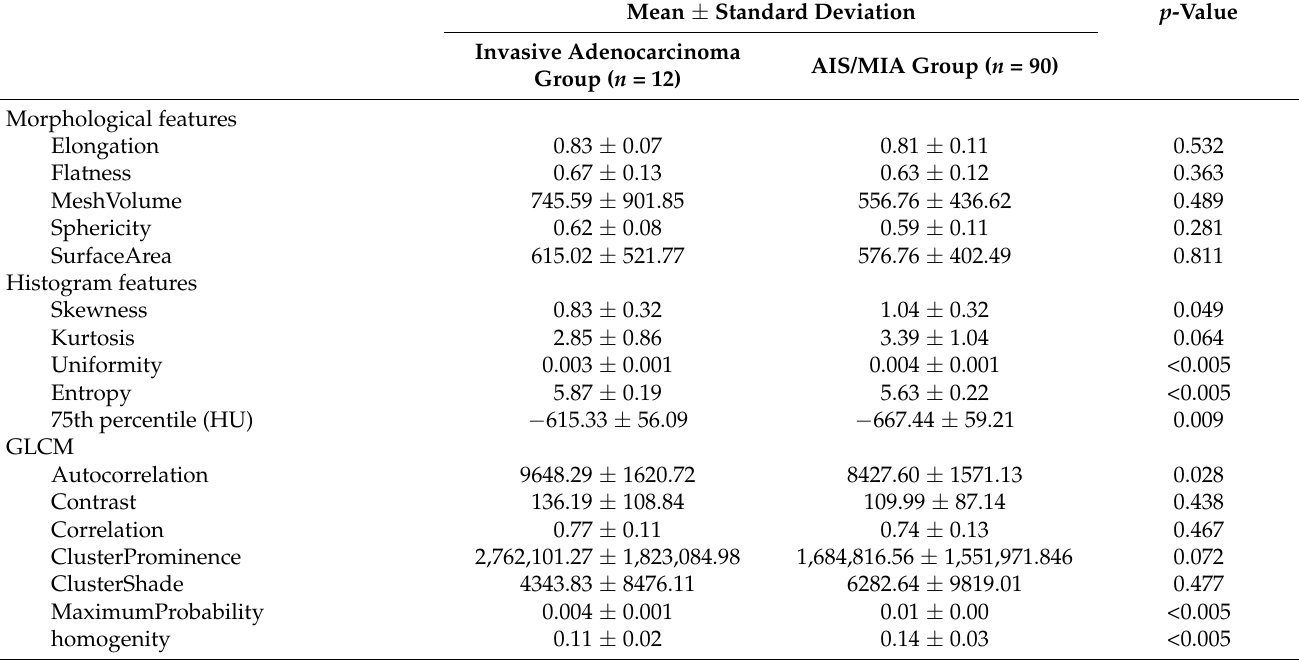
Table 4. Radiomic features of pure ground-glass nodule